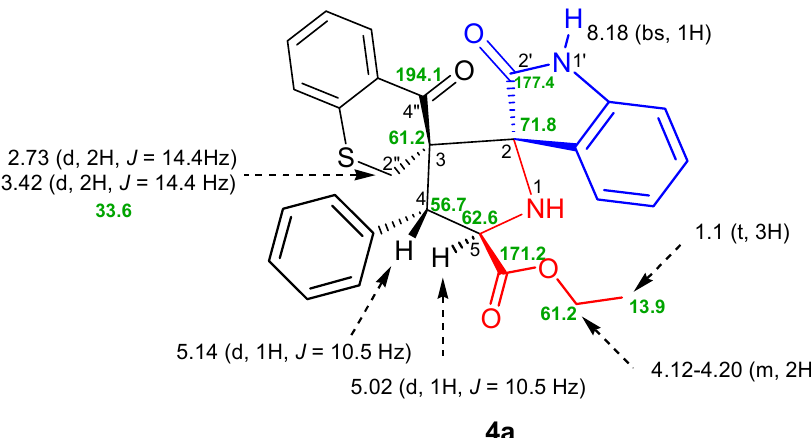
Figure 2. 1 H (black) and 13 C { 1 H} NMR (green) chemical shifts (ppm) of the selected compound 4a (see also Figure S3 in the Supporting Material).